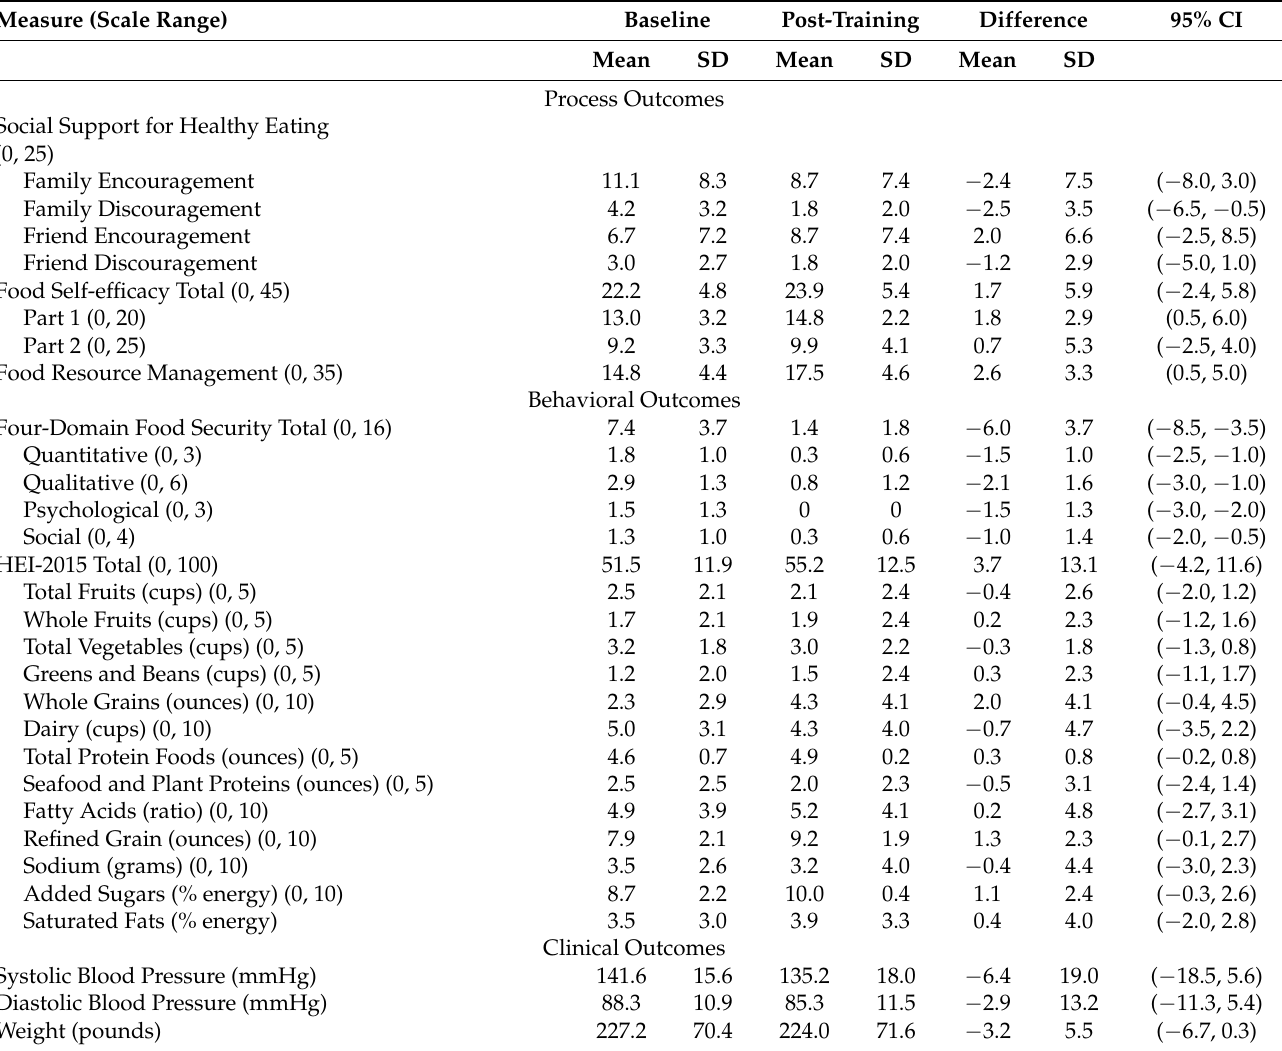
Table 4. The mean difference in participant outcomes from baseline to post-training